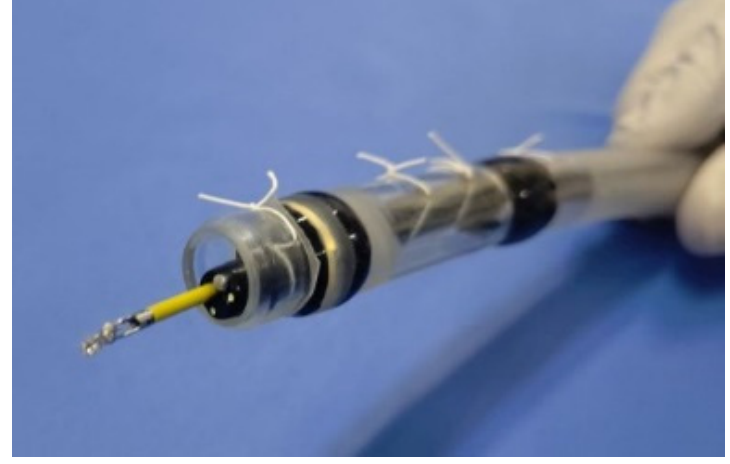
Figure 5. The biopsy forceps inserted via the forceps channel of the endoscope.